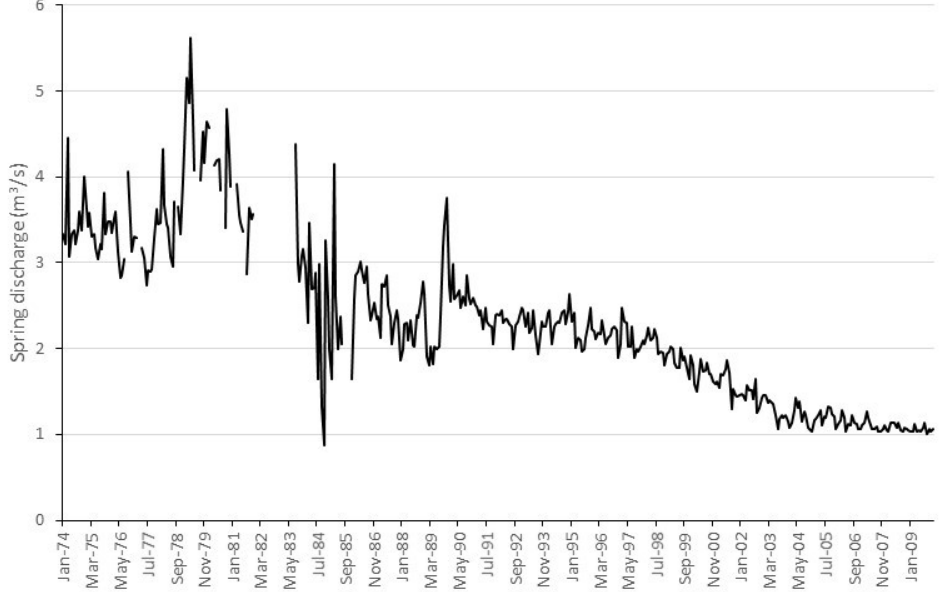
Figure 2. Hydrographs of the spring discharge of the Liulin spring (from January 1974 to December